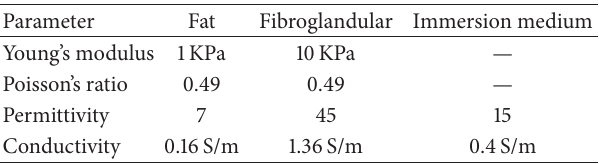
Table 1: Mechanical and electrical properties of the different tissues present in the numerical